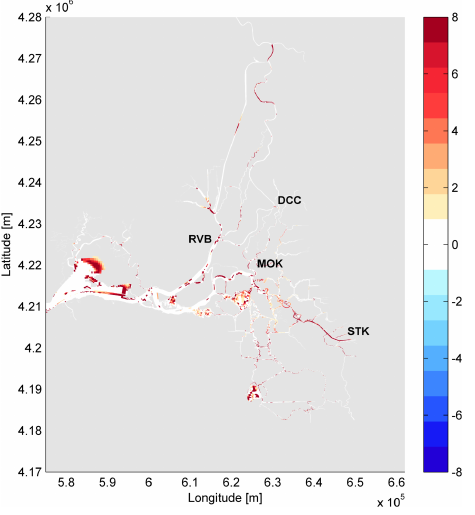
Figure 11. Modeled deposition in millimeters for 1 year period. Figure 12. Turbidity in each Delta region. For each region, the left bars indicates wet season and the right bars the dry season. The light gray bars indicate the mean turbidity over the region, the darker bars the spatial deviation and the lines the daily deviation. Each horizontal line represents